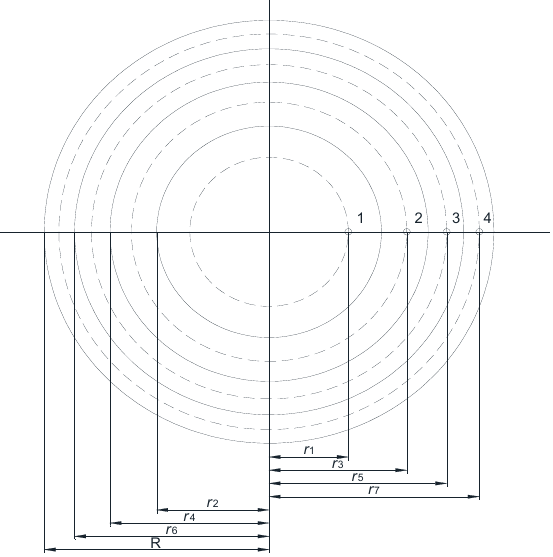
Figure 8. Arrangement of testing points in the air duct model (vertical view).